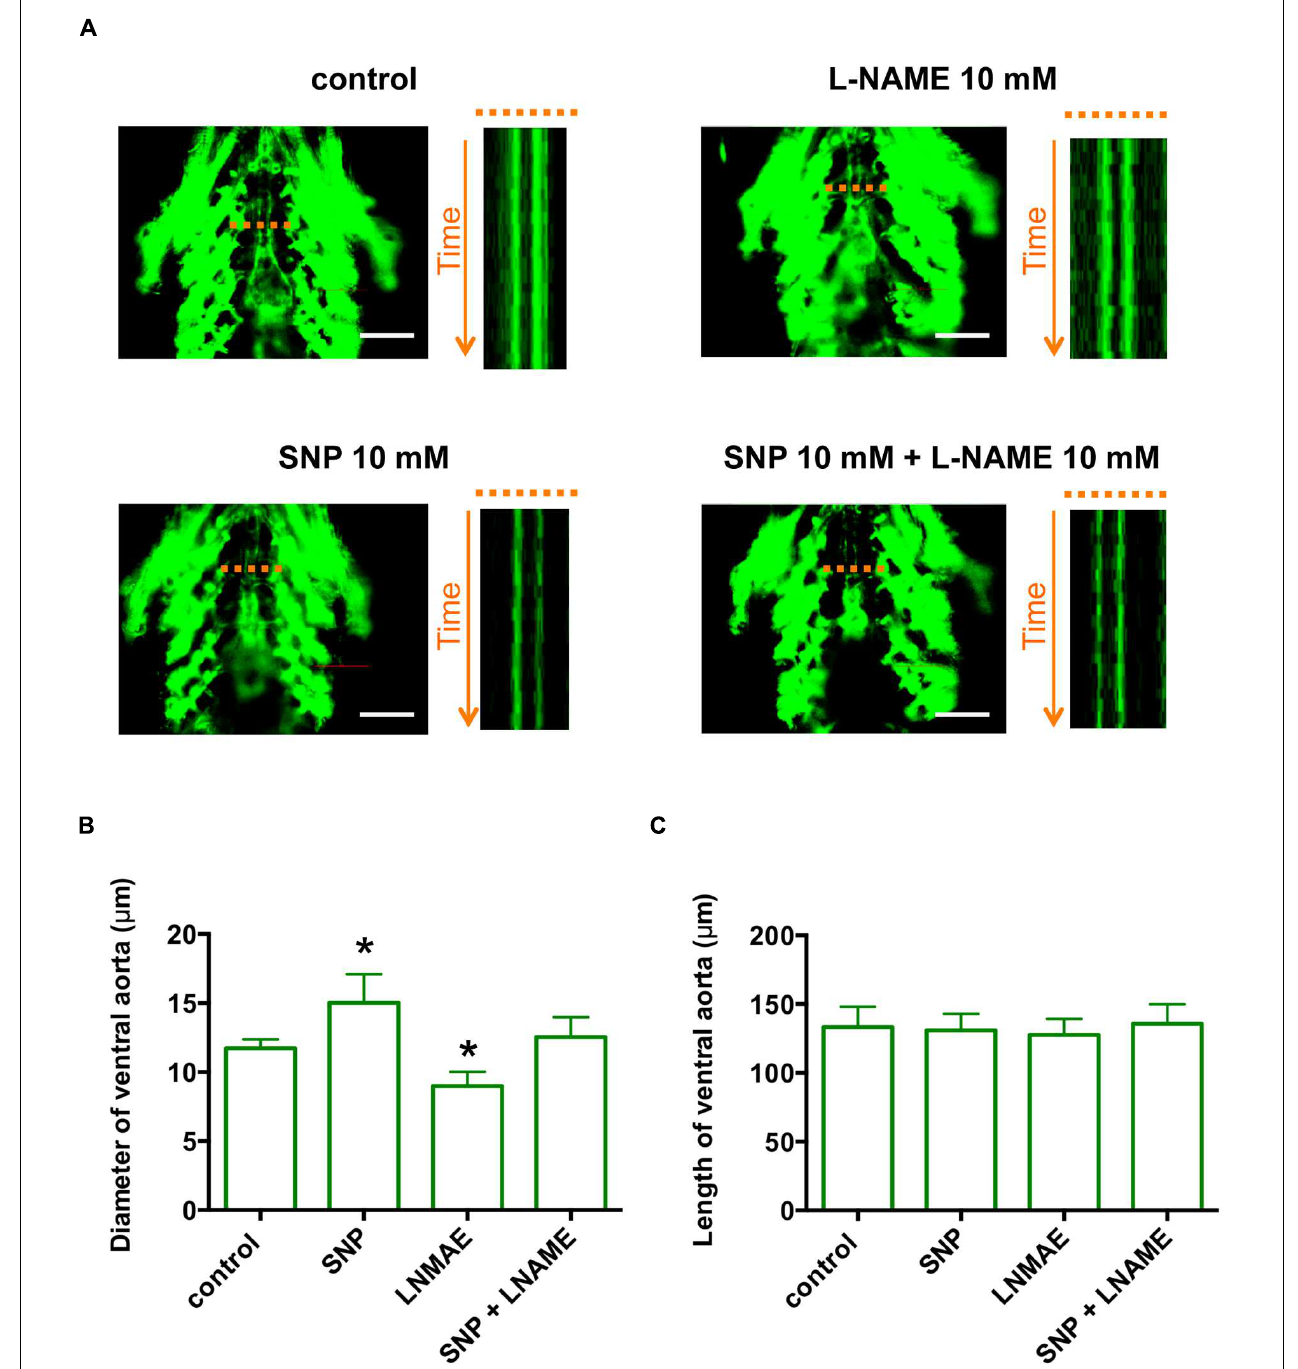
FIGURE 3 | The zebrafish ventral artery diameter is increased by a NO donor and decreased by a NO synthase inhibitor. (A) In vivo imaging of the ventral artery of Tg (fli1:EGFP) zebrafish at 6 dpf. Zebrafish were incubated with or without 10 mM Sodium nitroprusside (SNP) and/or 10 mM L -NAME for 2 h and then placed on microscope slides on their backs. The ventral artery was imaged under a fluorescent microscope at 100 frames/s for 5 s. The image stack projections and time-lapse imaging traces at the level of the ventral artery (dotted lines) are shown. Scale bars, 100 µ m. (B) The diameter of the ventral artery was increased and decreased by zebrafish treatment with SNP and L -NAME, respectively, relative to untreated zebrafish. The ventral artery diameter of zebrafish co-treated with SNP and L -NAME was not significantly different from that of control zebrafish. The ventral artery diameters were measured using time-lapse imaging. N = 5 for each group. ∗ p < 0.05 vs control. (C) The length of ventral artery in zebrafish treated with SNP and/or L -NAME was not significantly different compared to that in untreated zebrafish. N = 5 for each group.